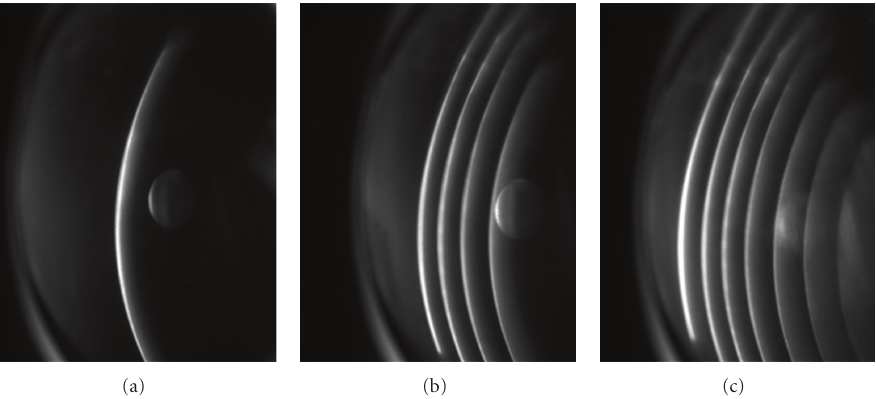
Figure 3: Example images of a fluorescing porcine cornea. Three images of projected patterns by the DMD bench top system (a) a vertical slit, (b) 4 parallel vertical slits, and (c) 7 parallel vertical slits.